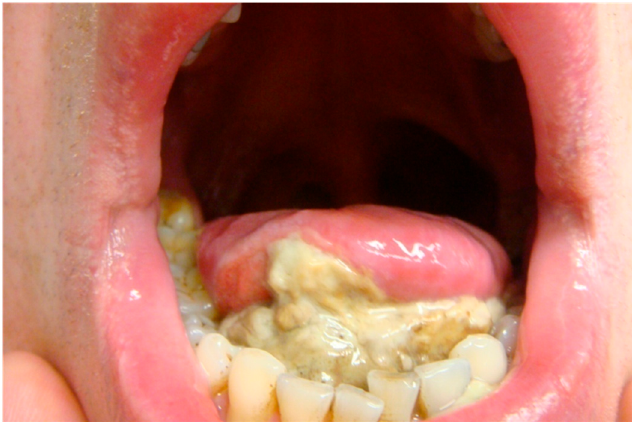
Figure 6. This image displays sloughing of necrotic tissue in the oral cavity post-PDT. Reprinted with permission from ref. [36]. Copyright 2011 Lasers Surg. Med.